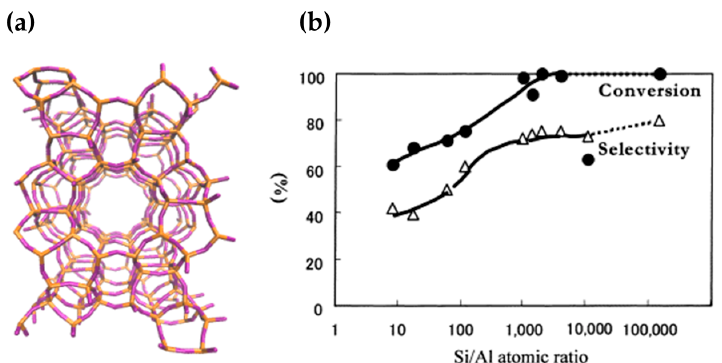
Figure 6. The MFI structure of Silicalite-1 ( a ), and the influence of Si/Al ratio on the conversion of cyclohexanone oxime (•) and selectivity to caprolactam ( ▵ ). Reaction conditions: cyclohexanone oxime (8 wt %) in benzene solution, WHSV = 3 h − 1 , 623 K ( b ) [68].